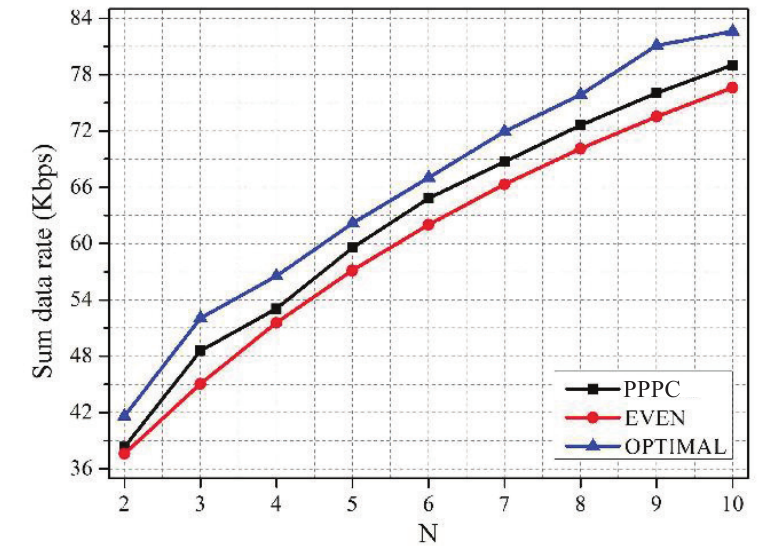
Figure 7. Sum data rate vs. N under schemes with different active probabilities of sensors. PPPC, priority-aware price-based power control.